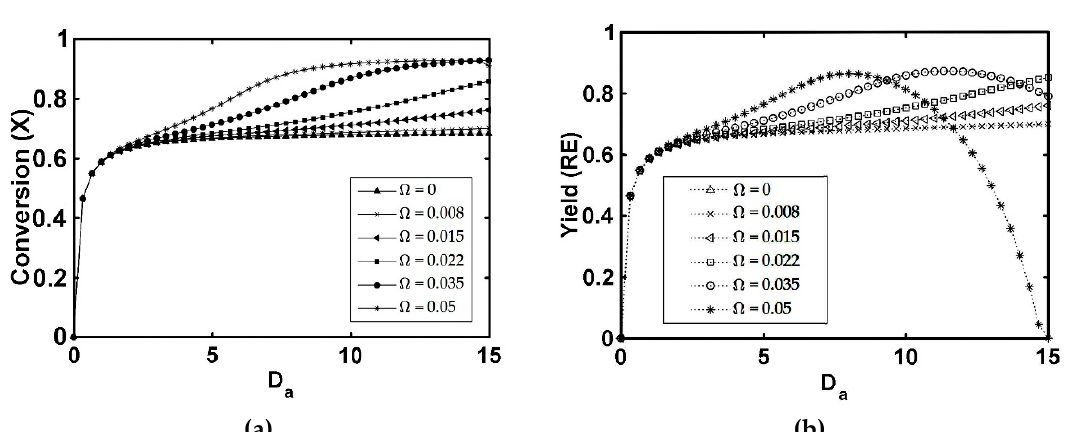
Figure 9. Isoamyl alcohol conversion ( a ) and ester yield ( b ) profiles in a ISPVMR ( Configuration 4 ), as a Function of D a and Ω .